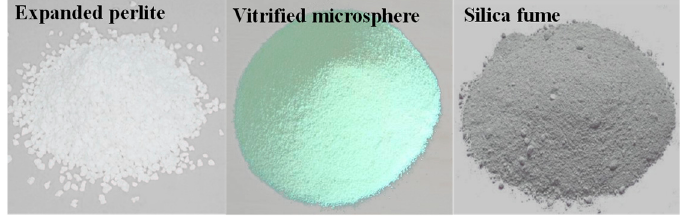
Figure 19. Inorganic materials for performance optimization of shotcrete.